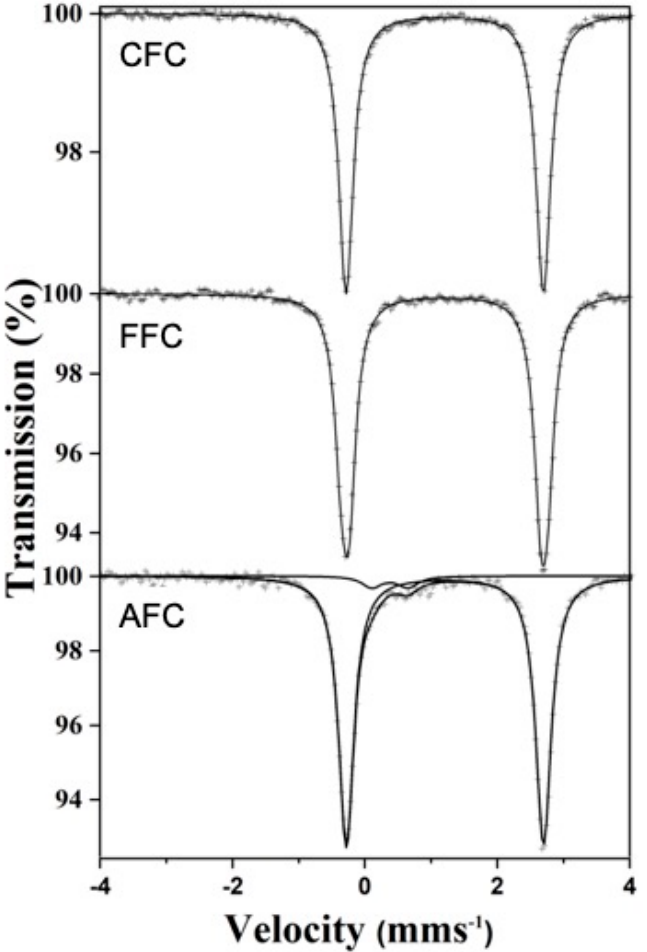
Figure 11. 298 K 57 Fe transmission Mössbauer spectra recorded from the various samples.